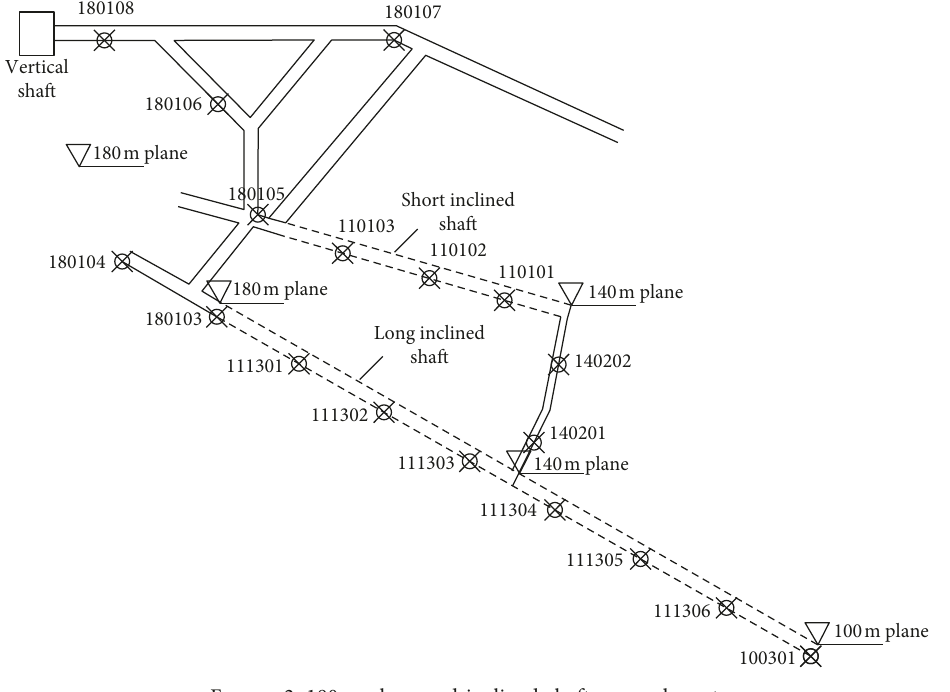
Figure 2: 180m plane and inclined shaft sensor layout.